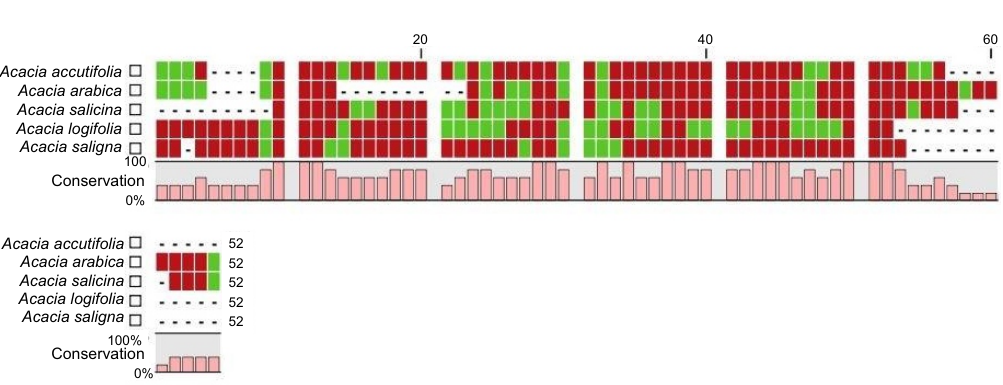
Fig. 2. Alignment of population structure of five Acacia spp.